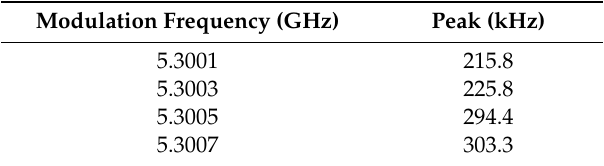
Table 2. The peak frequencies received for each modulation frequency.